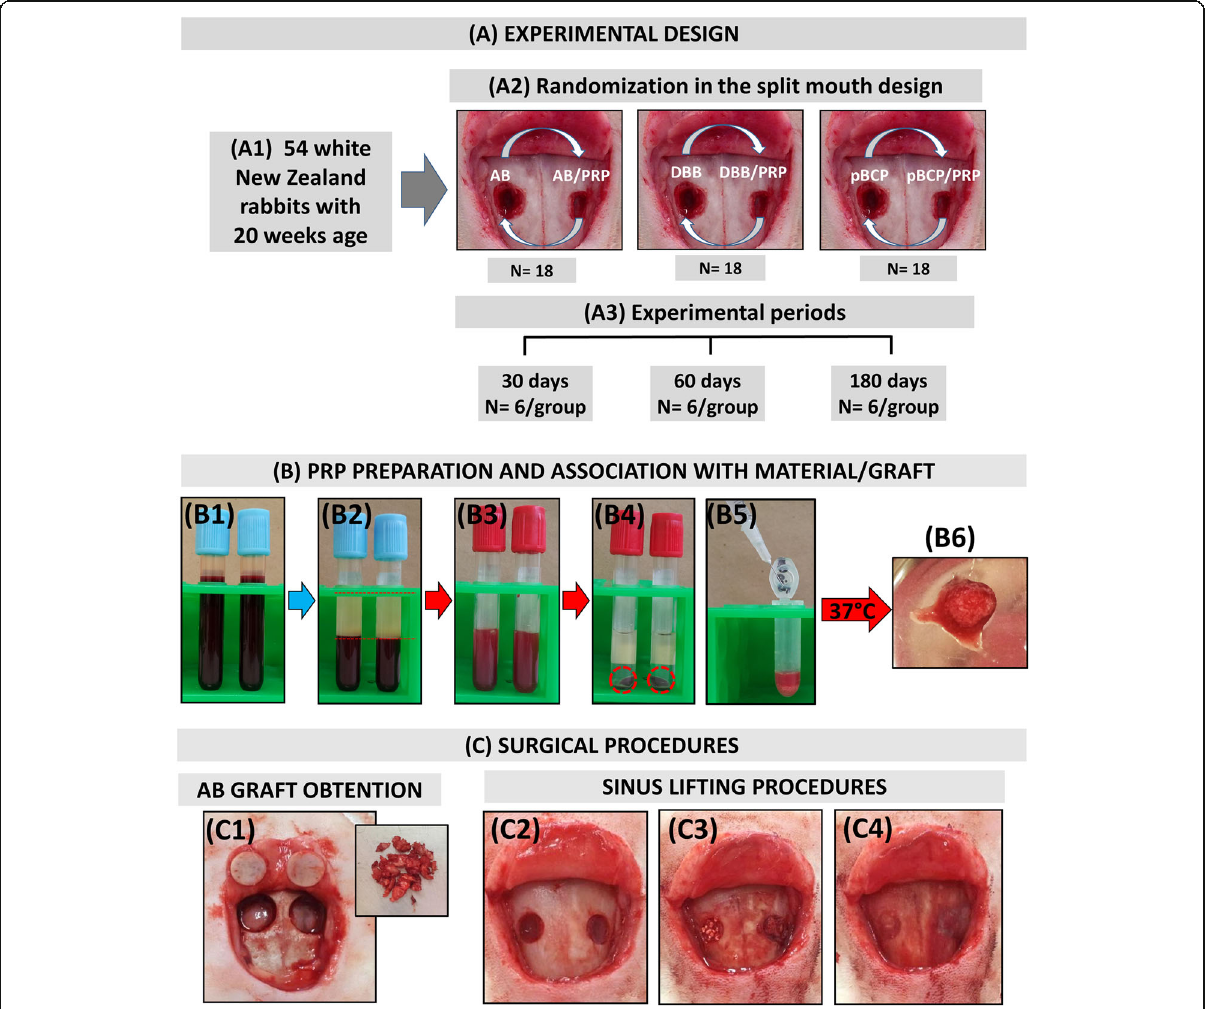
Fig. 1 Materials and methods . a Experimental design: scheme shows animal data and the randomization of MSA treatment with different materials homogeneity with clot or PRP. b PRP preparation and association with material/graft: ( B1 ) whole blood collected in two sterile glass tubes containing 3.8% sodium citrate. ( B2 ) PPP/PRP separated from red blood cells after centrifuge at 200× g (1200 rpm) for 10 min. (B3) PPP/PRP separated and transferred to a tube without anticoagulant. ( B4 ) After centrifugation at 200× g for 15 min note the separation of PPP and platelet plug (0.5 mL). ( B5 ) PRP added to a sterile tube containing the space filler plus 0.06 mL of 10% CaCl solution. ( B6 ) Tube immediately transferred